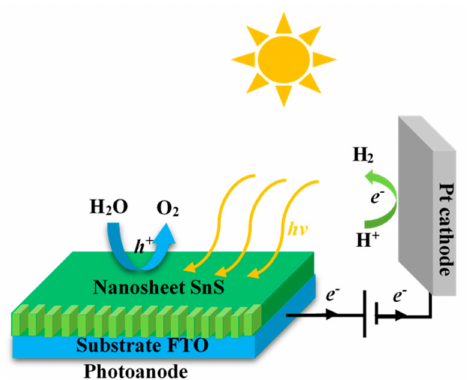
Figure 1. Architecture of a vertically aligned 2D SnS nanosheet-based photoanode used in this